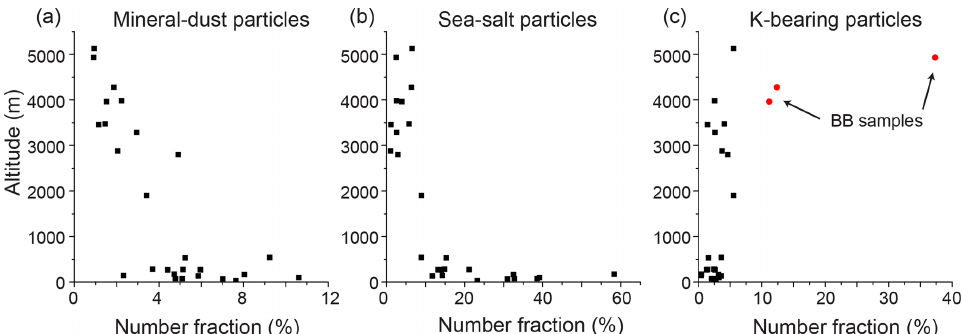
Figure 4. Vertical changes in the number fractions (%) of (a) mineral-dust, (b) sea-salt, and (c) K-bearing particles. Each plot indicates the number fraction of a given sample. The number of particles in the samples ranges from 216 to 442. The red solid-circle points in the K-bearing particle plots indicate the samples originating from the biomass burning plume (BB samples).